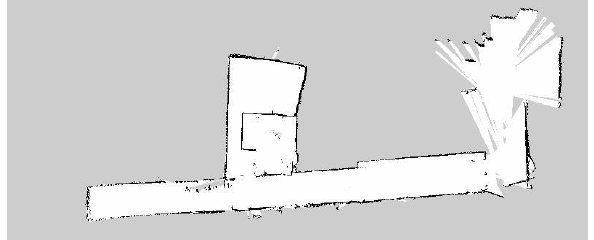
Figure 8. The floor plan from Kinect sensor